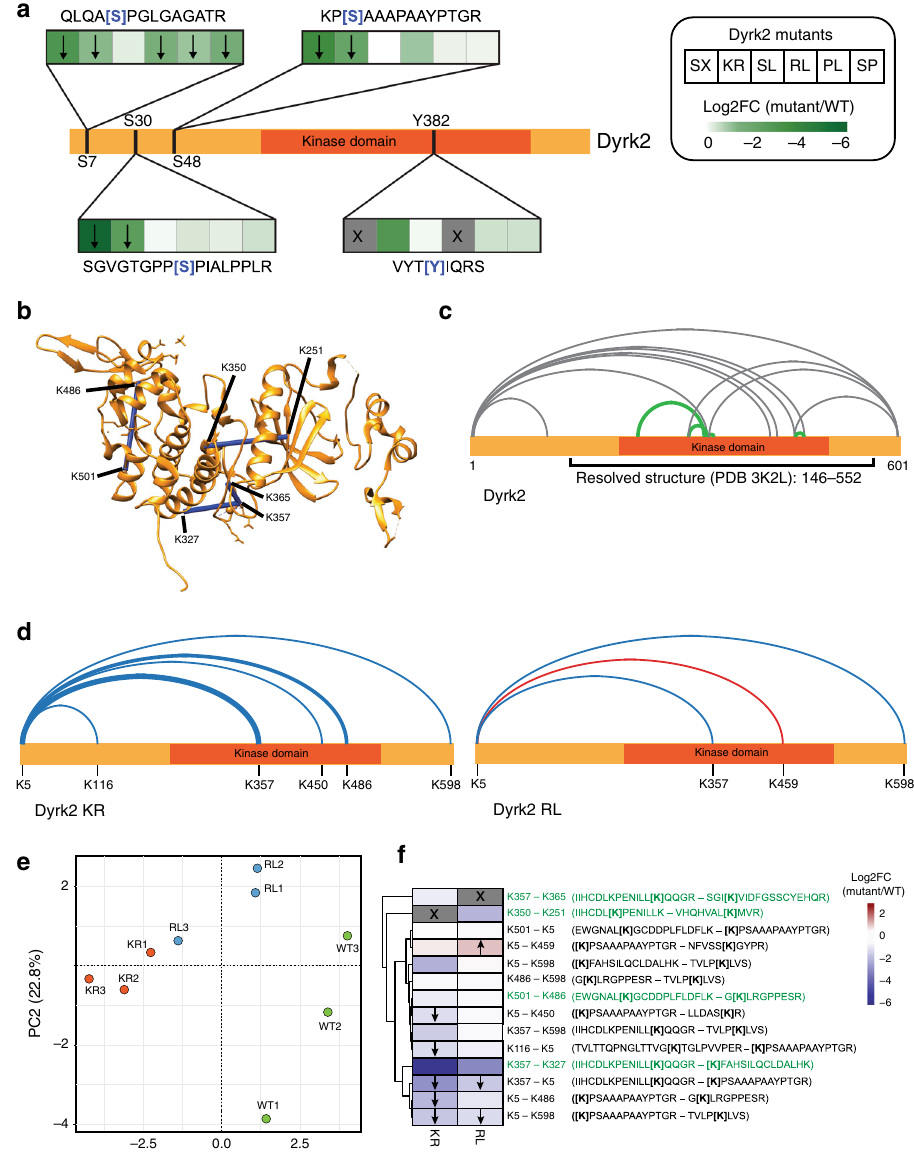
Fig. 5 Differential topological analysis of cancer-related Dyrk2 mutants by cross-linking MS. a Effect of cancer-related mutations on the phosphorylation status of Dyrk2 measured by AP – MS. The arrow indicates the direction of a signi fi cant change in phosphorylation ( p -value ≤ 0.05). Statistical analysis was performed with two-tailed unpaired Student ’ s t -test. The cross represents conditions in which no peptide could be detected. b Mapping of intraprotein cross-links that satisfy the distance threshold (~30 Å) of the cross-linker DSS to the structure of Dyrk2 (PDB: 3K2L). The Dyrk2 structure comprises the region between the amino acids 146 – 552 and lacks the N- and C-terminal part of the protein. c Visualization of con fi dently identi fi ed intraprotein cross- links (ld score ≥ 25). In green are shown cross-links that are validated by the known structure of Dyrk2. Gray lines represent cross-links that are located in regions for which structural information is missing. d Visualization of cross-links affected by selected point mutations in Dyrk2. Blue and red lines indicate a signi fi cant downregulation (blue)- or upregulation (red) of the cross-link (adj. p -value ≤ 0.05). Statistical analysis was performed with two-tailed unpaired Student ’ s t -test and p -values were adjusted using the method of Benjamini – Hochberg 67 . The thickness of the line stands for the degree of the change. Cross-links that were not affected by the mutations are not shown. e Principal component analysis (PCA) of quanti fi ed cross-linked peptides between wt Dyrk2 and its mutant variants. f Heatmap showing the effect of selected Dyrk2 point mutations on the abundance of cross-linked peptides. The arrow indicates the direction of a signi fi cant change in peptide abundance (adj. p -value ≤ 0.05). Statistical analysis was performed as in d . The cross indicates cross-linked peptides that could not be detected due to a mutation of the cross-linking residue (KR mutant) or the cleavage site (RL mutant). Cross-linked lysine residues are shown in brackets and structurally validated cross-linked peptides are highlighted in green. Source data are provided as source data fi